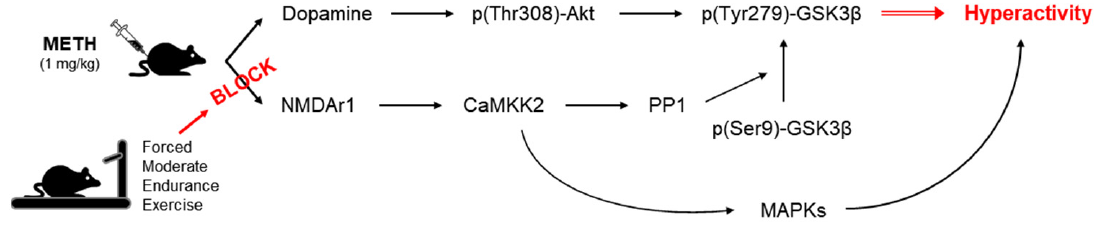
Figure 5. Summary of research results. METH, methamphetamine; NMDAr1, N-methyl-D-aspartate receptor 1; GSK, glycogen synthase kinase-3; MAPK, mitogen-activated protein kinase; CaMKK2, calcium/calmodulin-dependent protein kinase kinase 2; PPI, protein phosphatase 1.